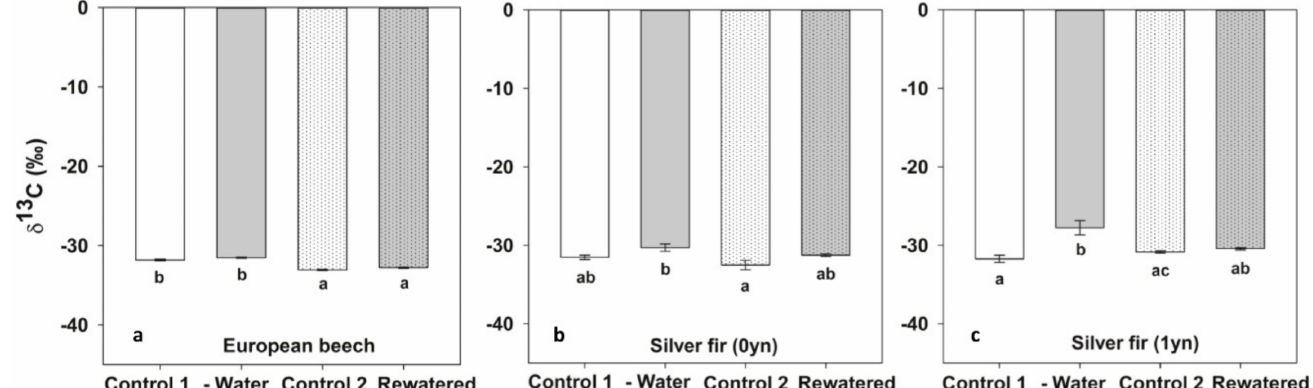
Figure 3. Foliar δ 13 C abundance of beech ( F. sylvatica L.) ( a ) and silver fir ( A. alba Mill.) ( b , c ) seedlings. 0yn, current − year needles; 1yn, one − year needles. Significant differences between controls and treatments are indicated by different letters ( p ≤ 0.05; n = 80). Values shown are means ± SD.